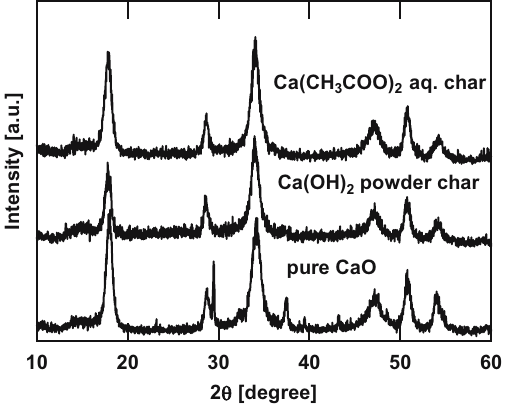
Figure 9: X - ray di ff raction patterns for the chars of the Ca - loaded co ff ee grounds and CaO.